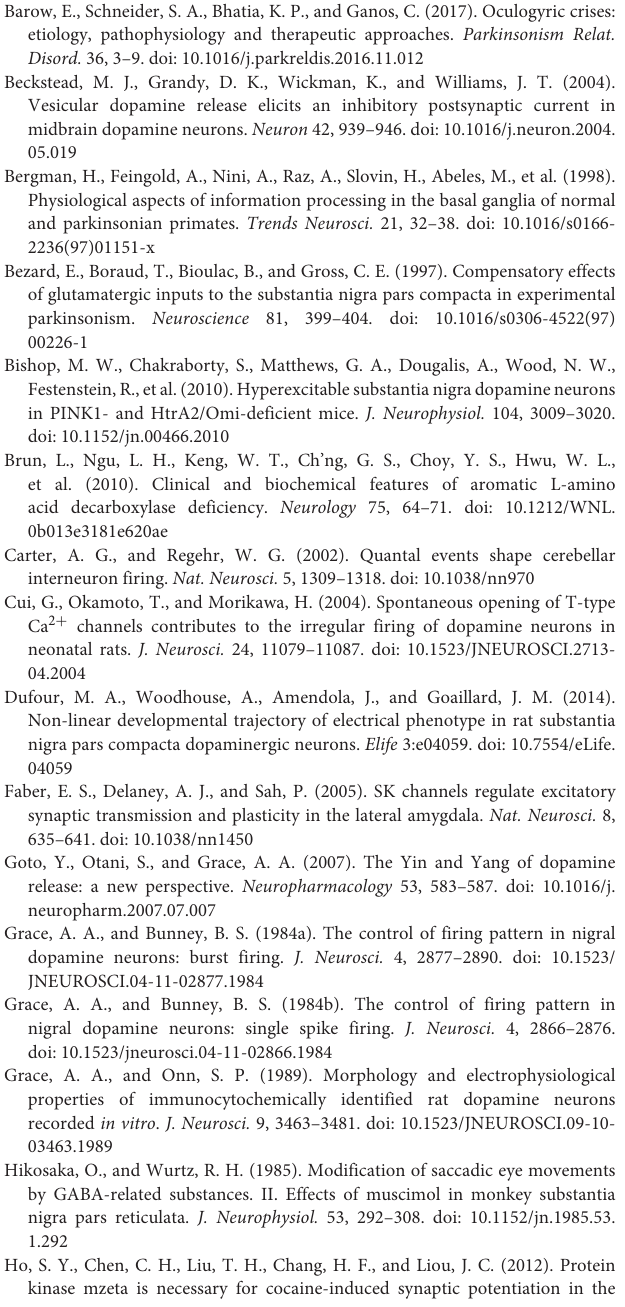
FIGURE S1 | DA neurons identification in the SNc. Immunofluorescence staining of a SNc neurons filled with biocytin through the glass recording electrode. The TH staining (green), biocytin (red), and colabeling of TH and biocytin are shown. Scale bar, 50 µ m. FIGURE S2 | NMDA-induced bursting in ex vivo brain slice. (A) The representative traces of spontaneous firing from WT and Ddc KI mice. The WT DA neurons typically displayed higher regular firing activity, and exhibited “bursting” firing pattern after NMDA application. In contrast, the Ddc KI DA neurons fired in a